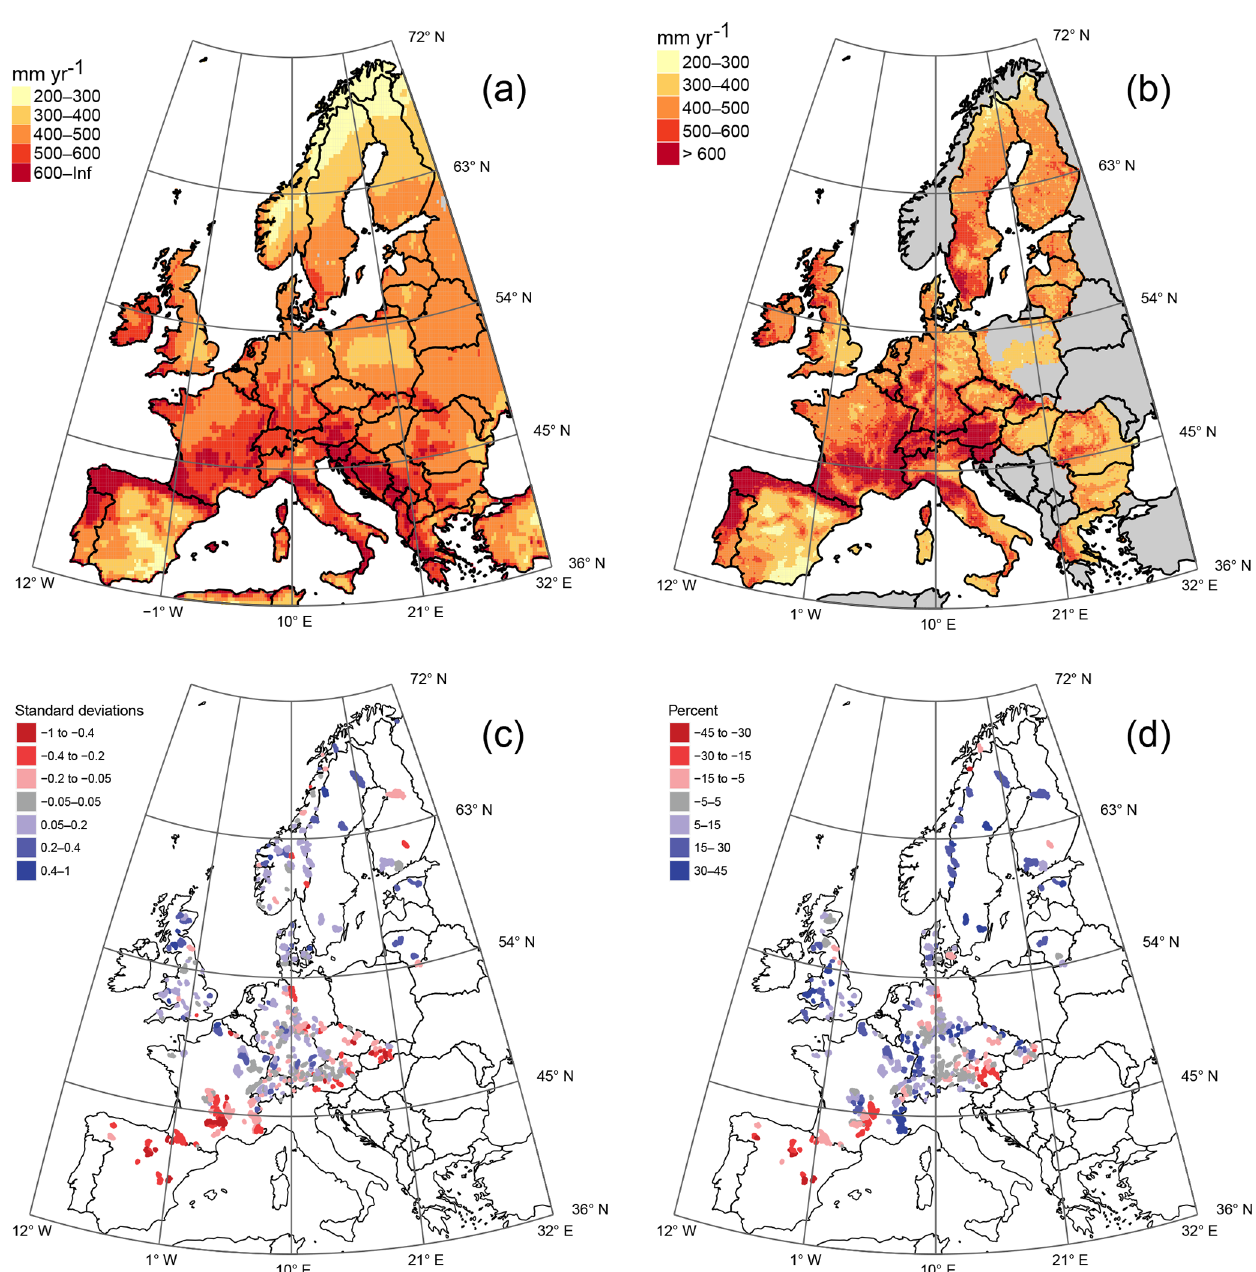
Figure 5. Validation of simulated hydrological fluxes across Europe. (a) Simulated ET average over the 10-year periods 1990, 2000, and 2010. (b) Observation-based ET average over the period 1980–2017 from GLEAM version 3.1 (Martens et al., 2017). (c) Simulated changes in streamflow between the periods 1960 and 2000. (d) Observed changes in streamflow over the period 1962–2004 taken from Stahl et al. (2010, their Fig. 2). Note the difference in units between simulations (c) and observations (d) because the approach followed in this study does not allow for normalization by interannual streamflow variability. Observed trends might also be calculated for shorter periods within the period 1962–2004. It should also be noted that ET validation is done for the mean flux, whereas streamflow is validated on the rate of change rather than the